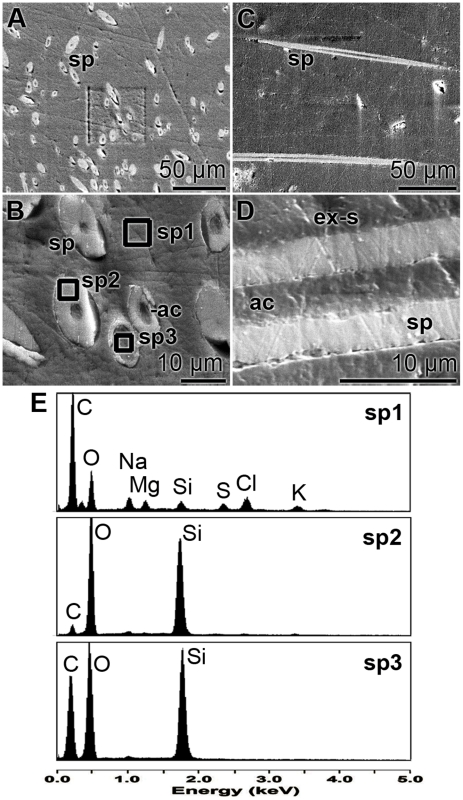
EDX analysess were performed of cross sections through primmorphs displaying growing spicules (sp).The sections were made in transversal (A and B) and in longitudinal orientation (C and D); SEM analyses. (E) EDX spectra from areas in the extra-spicular space (ex-s) [sp1], within the siliceous mantel of the spicule [sp2], and the region across the axial canal (ac) of one spicule [sp3]. The areas where the spectroscopic analysis were performed are marked in (B).